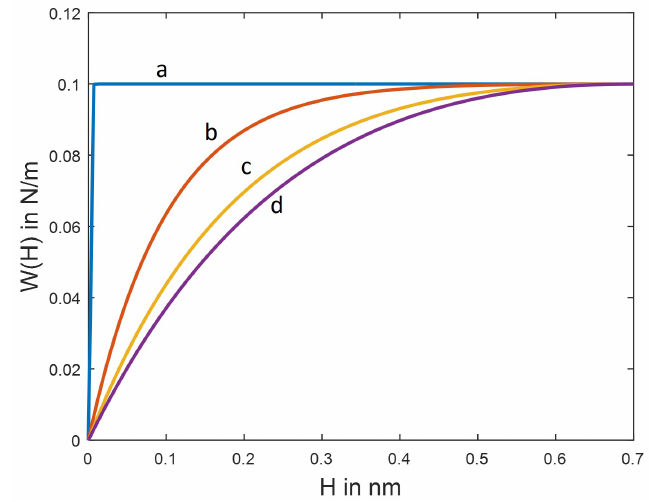
Figure 3. Adhesion potential W ( H ) with magnitude w = 0.1 N/m versus the slit width H dependent on the interaction length ξ : (a) ξ = 0.001 nm, (b) ξ = 0.1 nm, (c) ξ = 0.2 nm and (d) ξ = 0.3